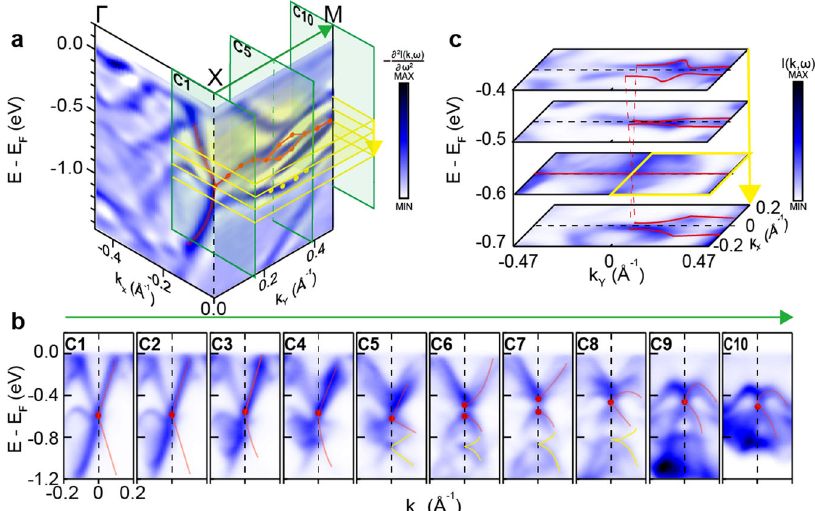
Fig. 2 Dirac crossings along the nearly fl at nodal line. a 2D curvature of the measured spectral image along the Γ – X – M direction. Red lines along Γ – X are guides to the eye of the dispersive band for the Dirac crossing at X . Markers along X – M indicate the fi tted positions of the band crossings from energy distribution curves. b Dispersions measured along the direction orthogonal to X – M as shown by green slices in a . Band crossings with unresolvable gaps are indicated by red arrows while gapped crossings are indicated by green and blue arrows. The second set of Dirac crossings are marked by yellow lines, where the crossing energies are marked as yellow markers in a . c Constant energy contours as indicated in a along X – M to show the evolution of the crossings leading to the nodal line around − 0.6 eV. Data are taken at 100 K. The polarization used is the same as in Fig.